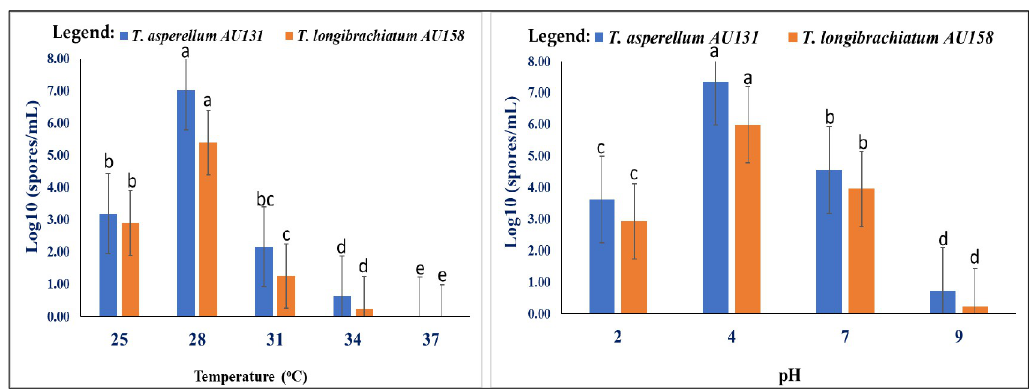
Fig 1. Effect of temperature and pH on Trichoderma species growth. Different alphabets depicted in superscript indicate mean treatments that are significantly different according to Tukey’s HSD posthoc test at p � 0.05 each value is an average of 3 replicate samples ± standard